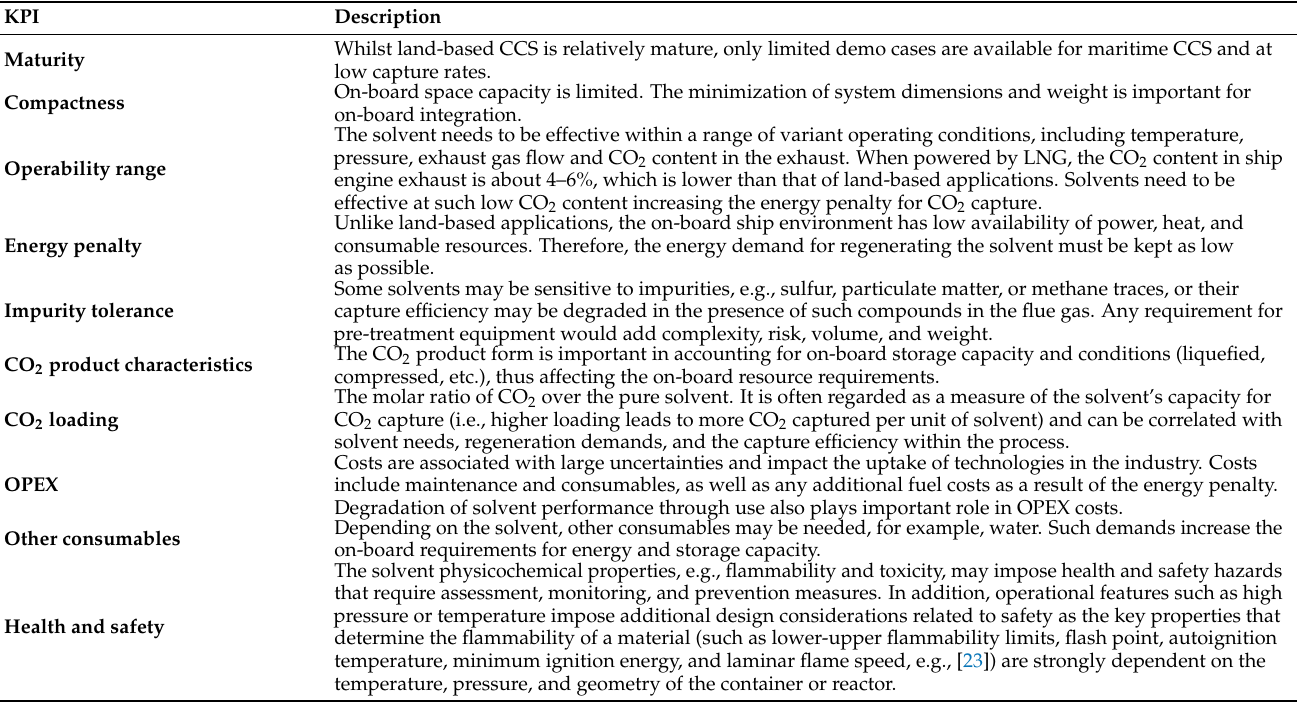
Table 1. Key performance indicators for on-board solvent-based CO 2